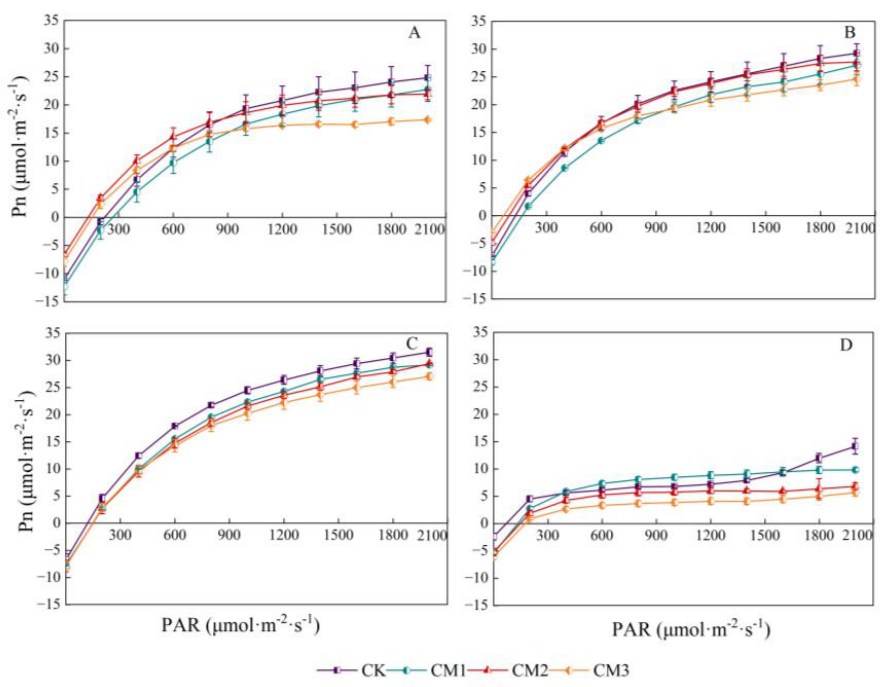
Figure 5. Light-response curves of cotton net photosynthetic rate (Pn) under different configuration modes. ( A : seedling period; B : budding period; C : flowering and boll development period; D : maturation period.).